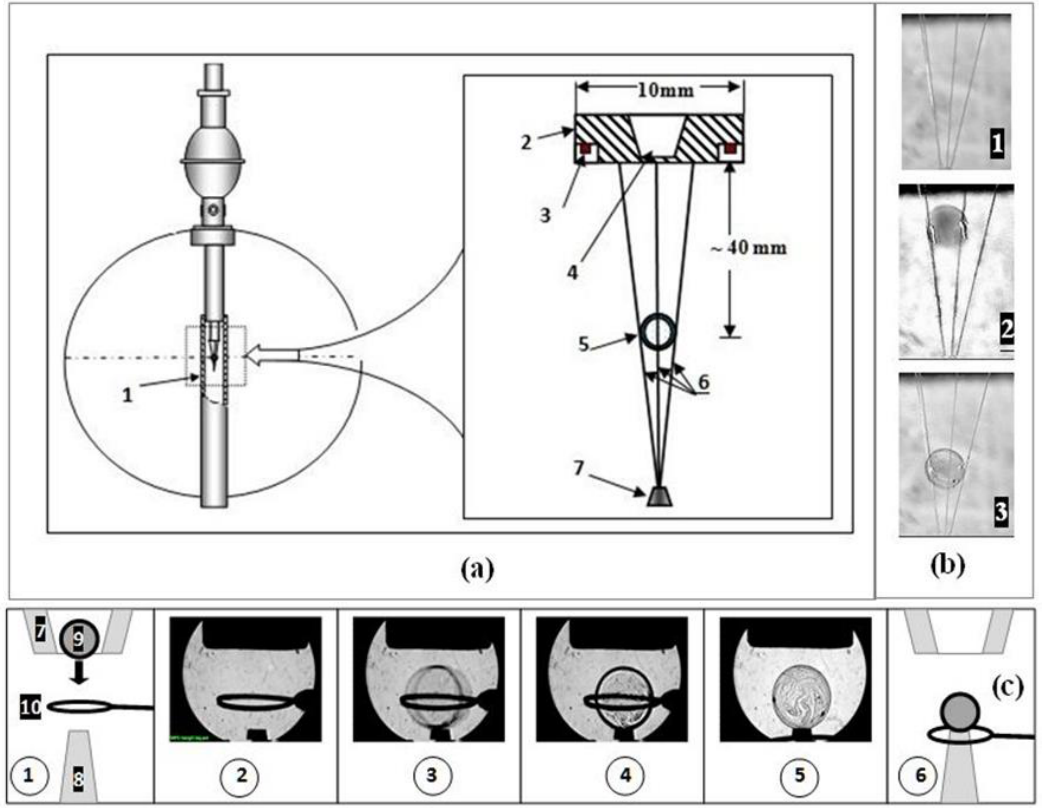
Figure 10. On-holder injection experiments at 300 K (1-6 is the sequence of video frames of the experiment): ( a ) free target positioning onto the TC bottom; ( b ) target injection to a special cylindrical cavity imitating a hohlraum-like unit; ( c ) target injection to a circular PMG-holder.